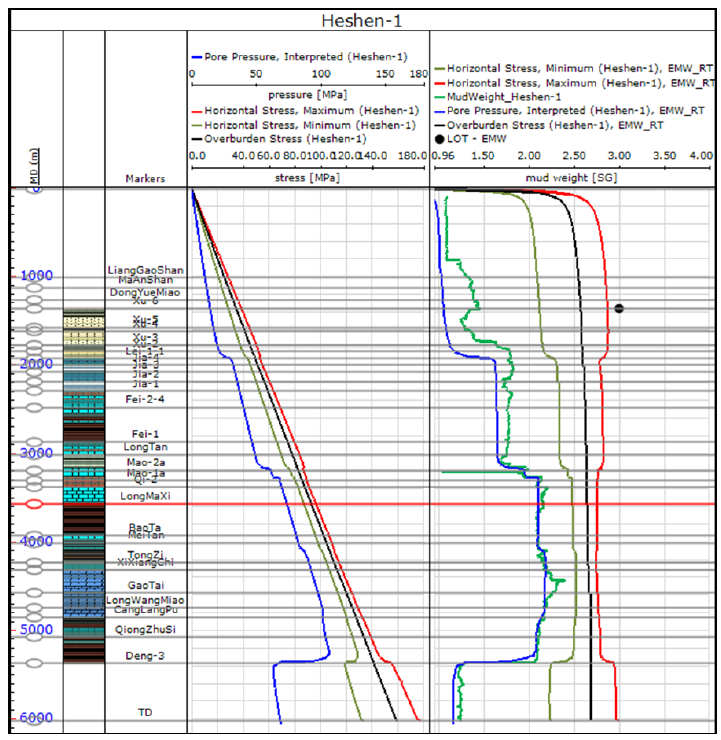
Figure 23. Final stress and pore pressure model for H1.